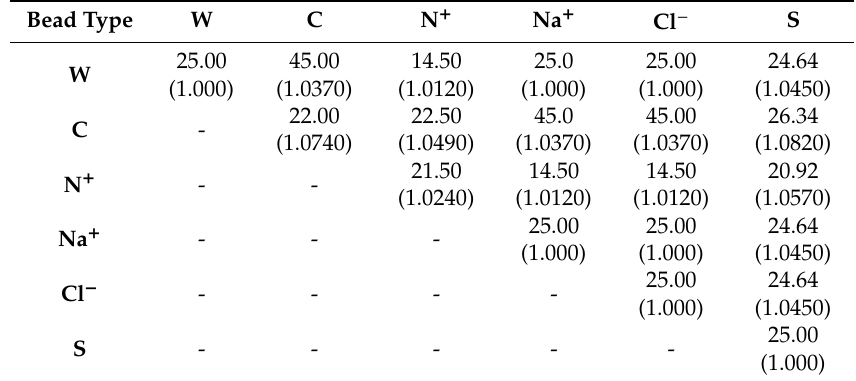
Table 1. Maximum repulsion parameters a ij r c / k B T and scaled cuto ff distances r cs (in the brackets) listed for all the components in the coarse-grained